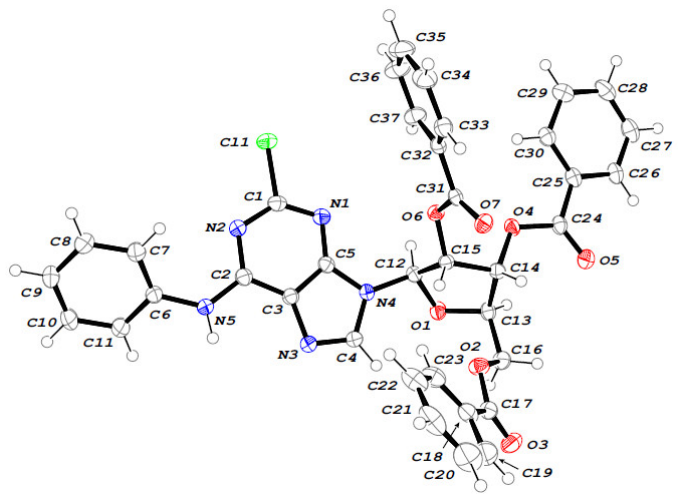
Figure 3. An X-ray diffraction analysis of purine 13. An ORTEP diagram was drawn with a 40% ellipsoid probability level.